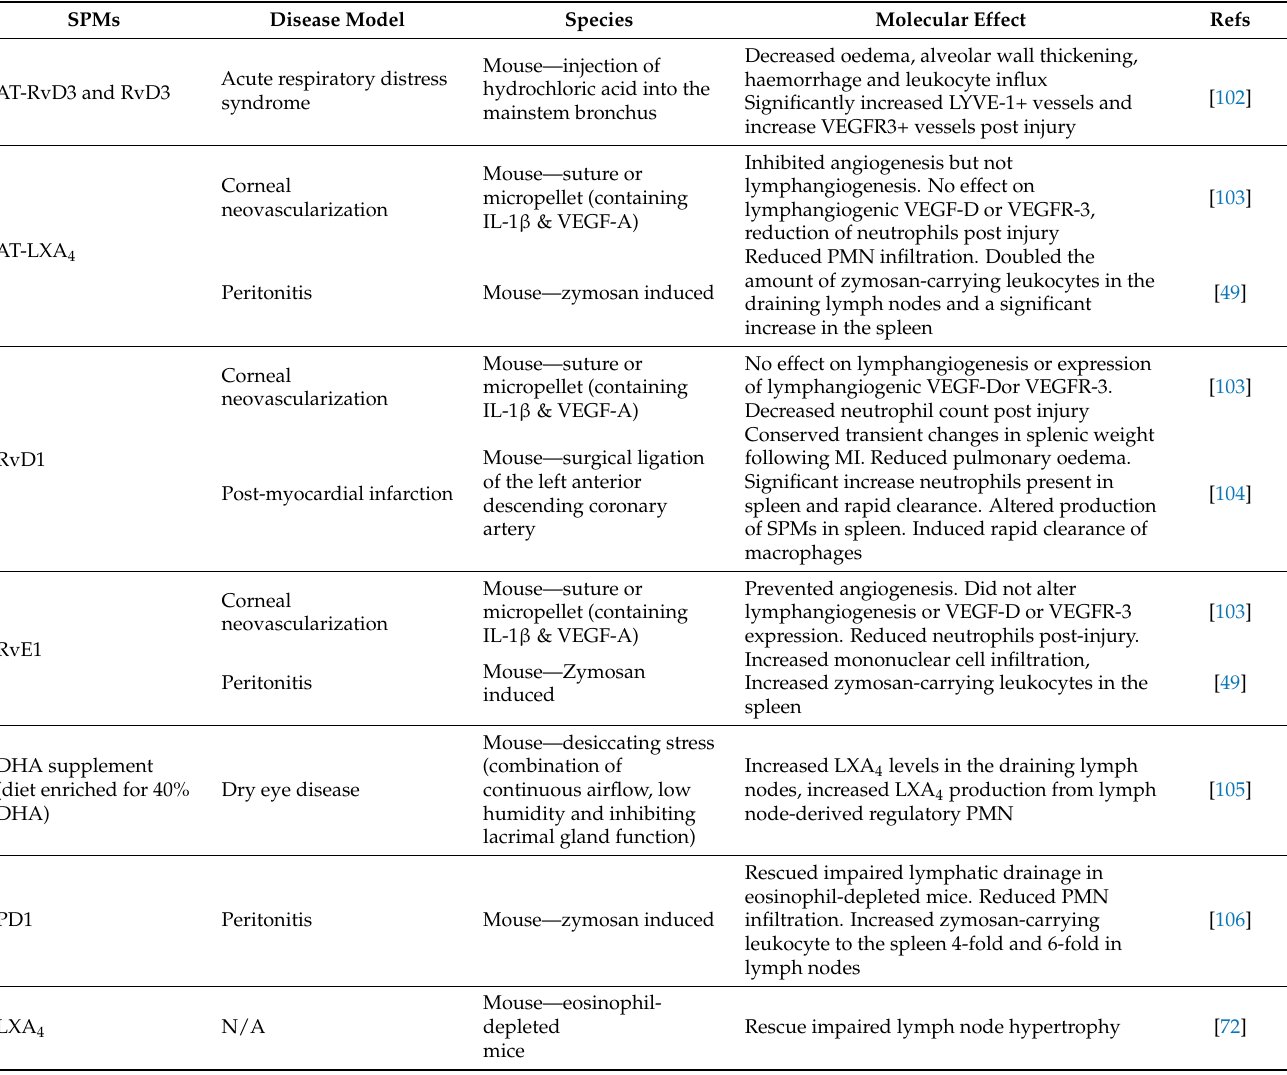
Table 1. Role of specialized pro-resolving mediators in lymphatic